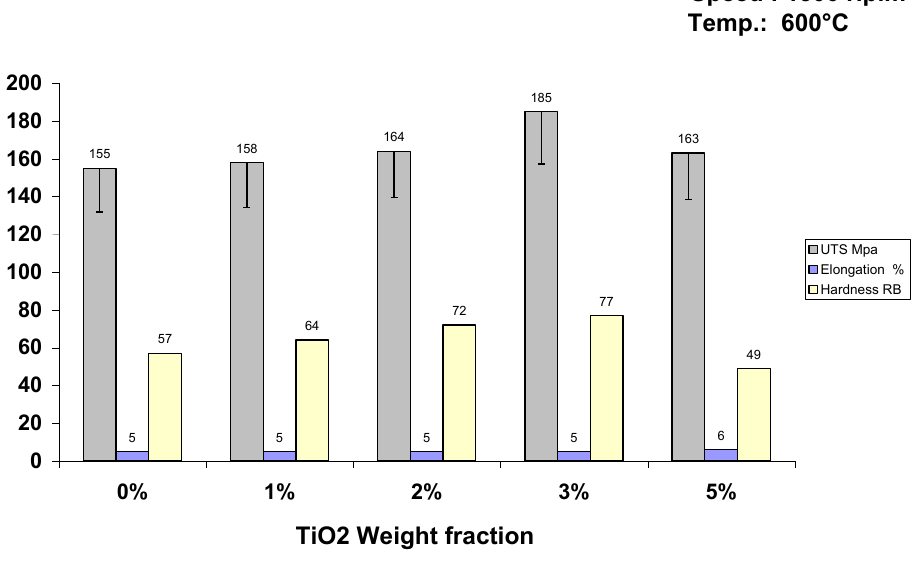
Figure 3. The effect of TiO 2 nanoparticles% on the UTS, hardness and ductility using 1500 rpm stirring speed at semi-solid state (600 °C).